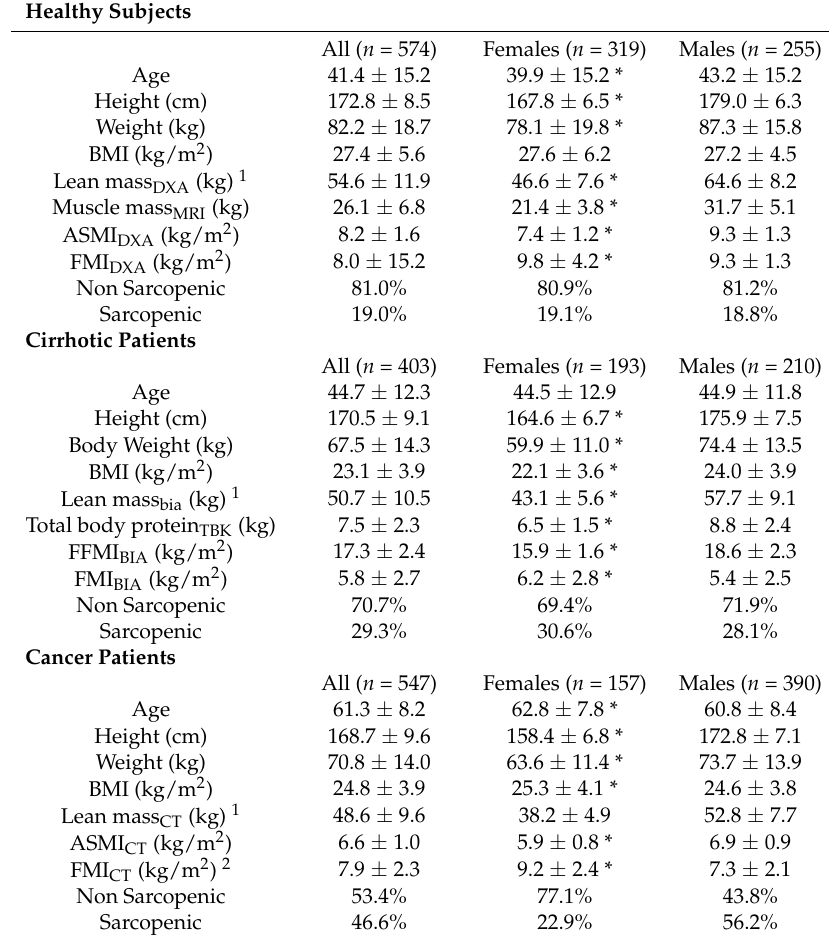
Table 1. Characteristics of healthy subjects, cirrhotic and cancer